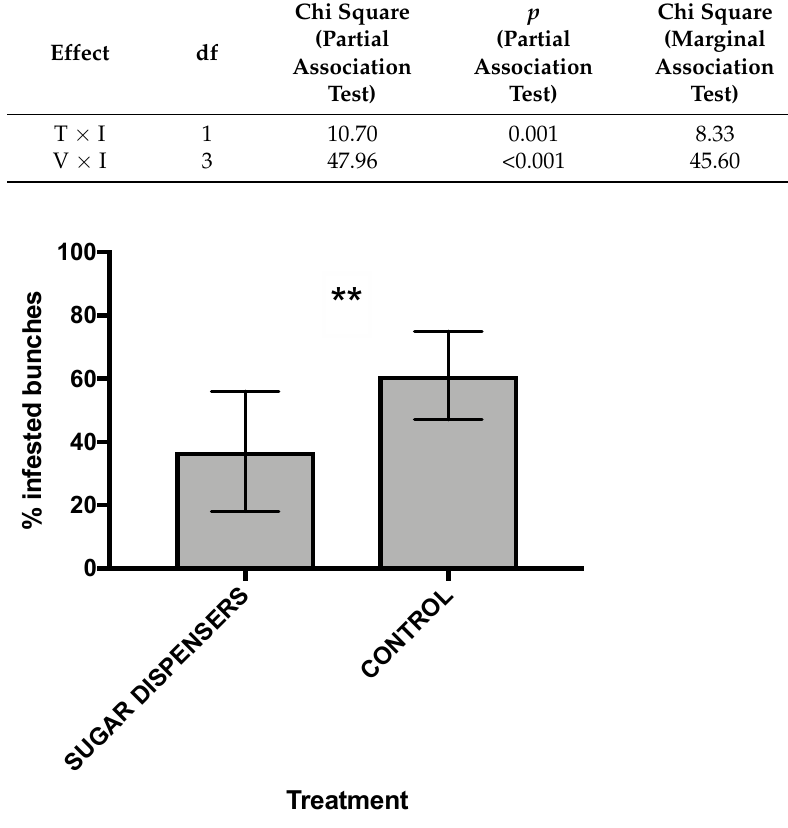
Figure 6. Mean percentages of infested bunches ( ± SE) ( n = 4). Log linear analysis showed a significant difference between the two treatments (** = p < 0.01).